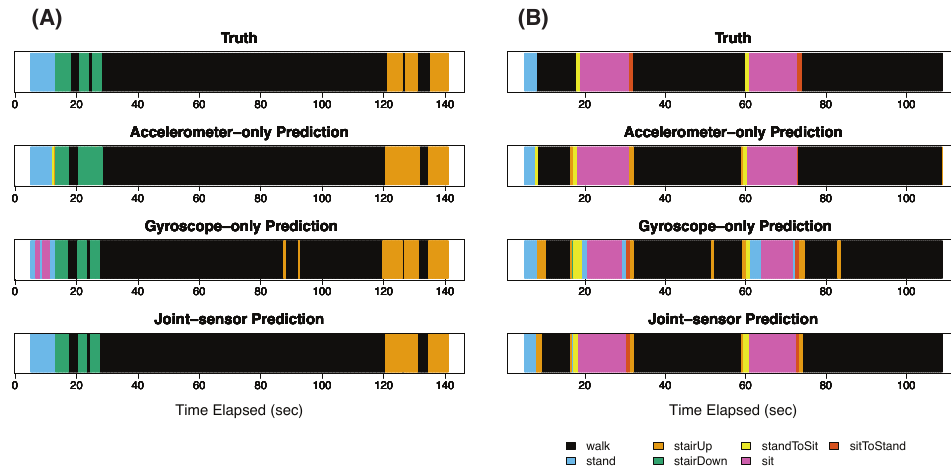
Figure 3. Steps 1 and 2 for participant 3. Panels ( A , B ) show the results for participant 3 in steps 1 and 2, respectively. For each panel, four figures are shown. The top figure gives the true activity labels based on video footage. The second figure shows the activity classifications from the accelerometer- only method, the third figure shows the classifications from the gyroscope-only method, and the fourth shows the classifications from the joint-sensor method. In each row, the horizontal axis gives the time elapsed, measured in